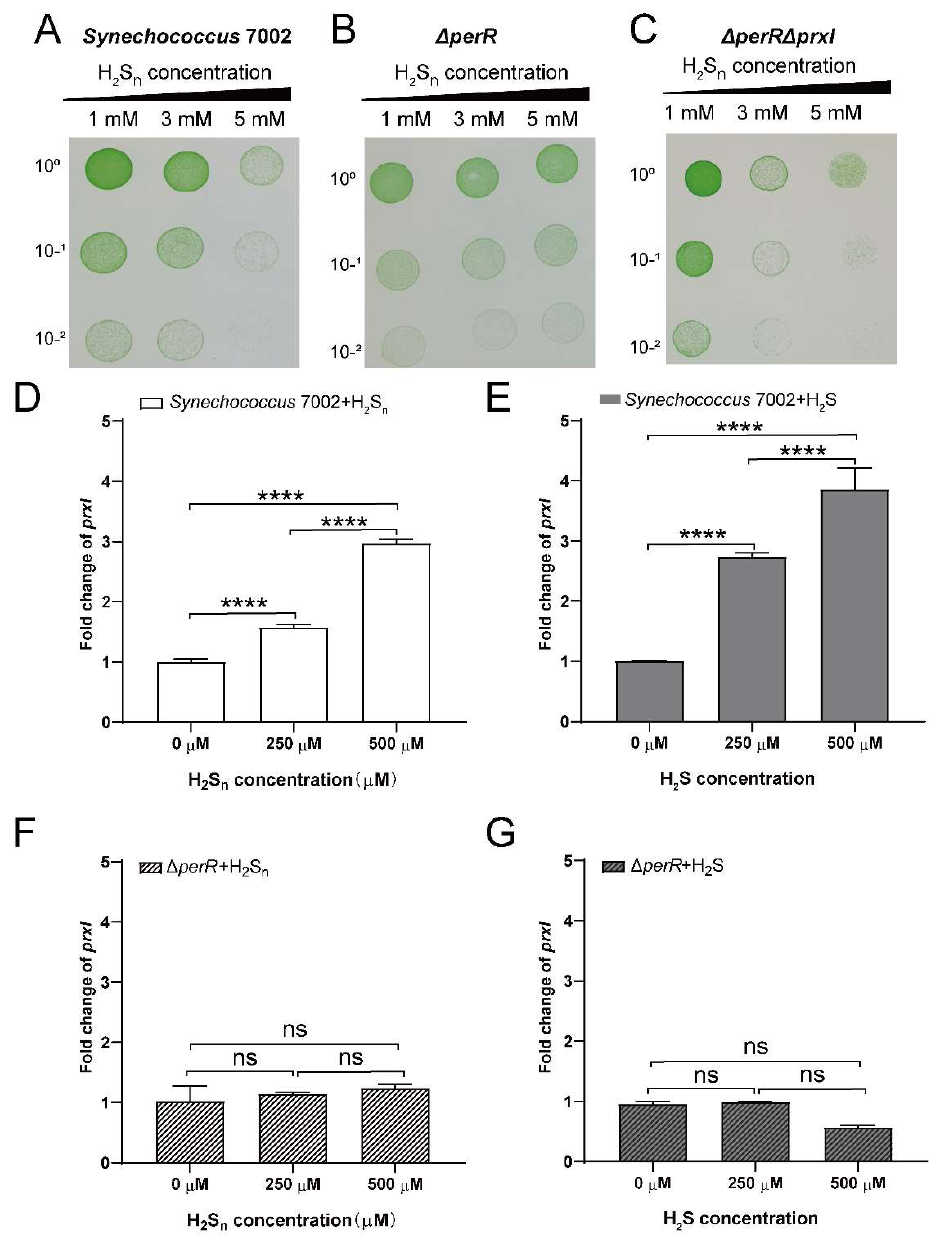
Figure 2. PerR decreases the tolerance of PCC7002 to H 2 S n . The deletion of perR (PCC7002Δ perR ) ( B ) increased H 2 S n tolerance, while the double deletion of perR and prxI (PCC7002Δ prxI Δ perR ) ( C ) decreased H 2 S n tolerance compared with the wild–type ( A ). PCC7002, PCC7002Δ perR , and PCC7002Δ prxI Δ perR cells at log phase with an OD 730 nm of 1 were treated with 1, 3, and 5 mM H 2 S n , at 30 °C, and 50 μmol photons m −2 ·s −1 illumination for 6 h. Then, cells were diluted with A + medium to 10 0 , 10 −1 , and 10 −2 , and plated onto the A + solid medium and cultured for 7 days, at 30 °C, and 50 μmol photons·m −2 ·s −1 illumination. The tolerance of PCC7002Δ perR and PCC7002Δ prxI Δ perR to H 2 S n was opposite to that of the wild-type. The expression of prxI was largely upregulated by H 2 S n ( D ) and H 2 S ( E ) in PCC7002, while H 2 S n ( F ) and H 2 S ( G ) showed little influence on its expression in PCC7002Δ perR . PCC7002 and PCC7002Δ perR cells at log phase were induced by H 2 S n and H 2 S with concentrations of 250 μM and 500 μM for 3 h, and the expression of prxI was measured. The Y-axis is the fold change in prxI calculated by relative quantitative qPCR, based on the 2 −ΔΔCT method, with rnp as the reference gene. All data are averages from three samples with standard deviations (error bars). The experiment was repeated at least three times. ****, p < 0.0001; ns, not significant (paired t test).